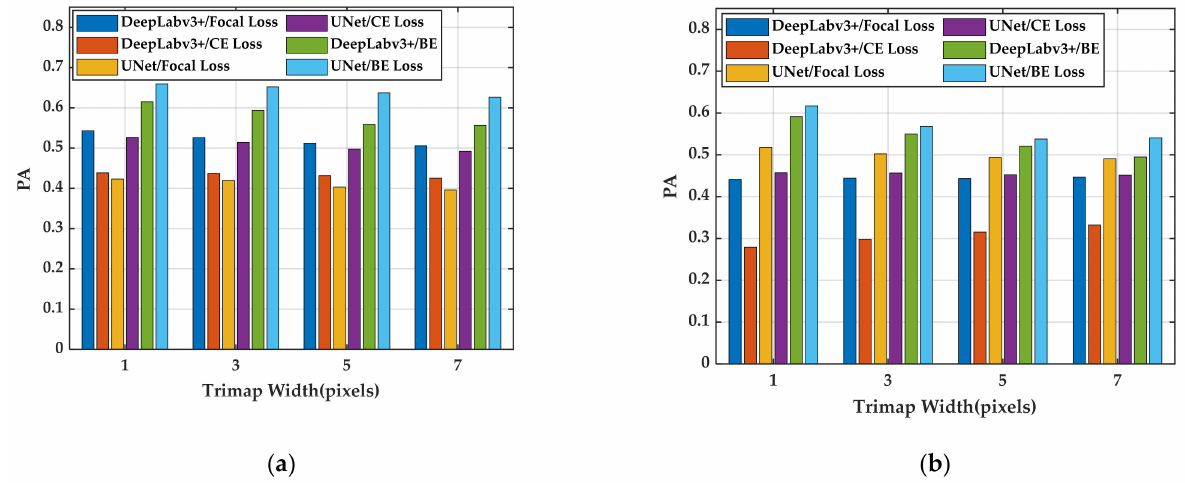
Figure 15. Results of the quantitative evaluation on the boundary segmentation effect based on trimaps. ( a ) YSH dataset. ( b ) HTI